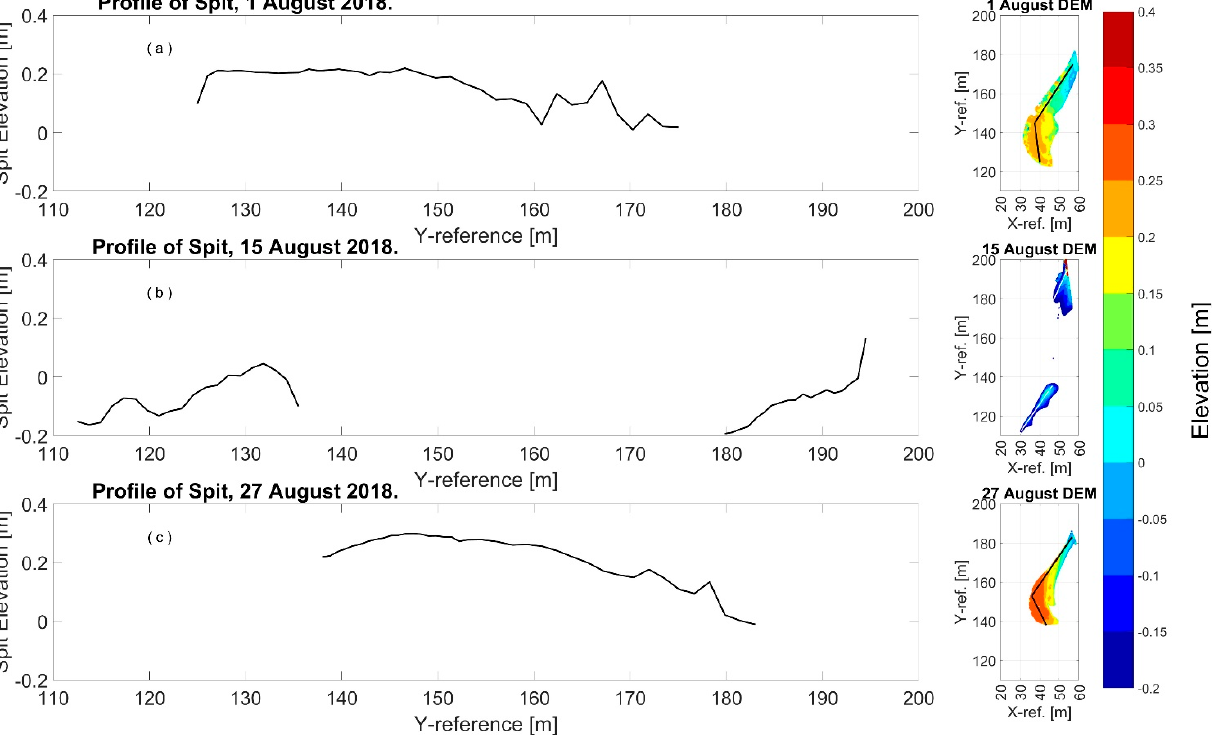
Figure 6. Spit profiles from ( a ) 1 August, ( b ) 15 August, and ( c ) 27 August, showing the spit before breaching, the breached spit, and the new spit profile, respectively. Right column panels show the digital elevation model, and the black lines (or white in the middle panel) are where the profiles (left panels) were computed.